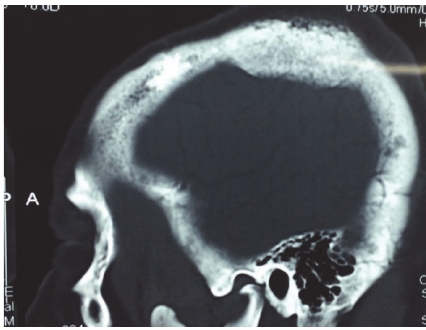
Figure 3: CT of the brain 12 months after androgen deprivation showing decrease in size of the parietal mass and bony